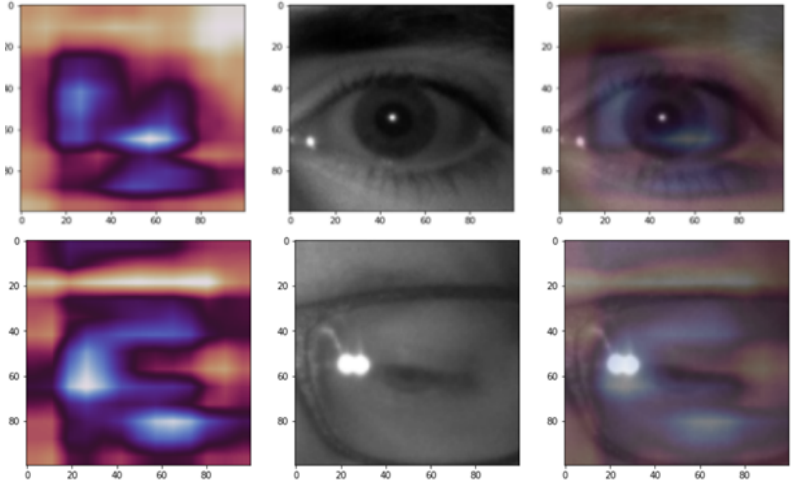
Figure 13. Activation map for open and closed eyes.